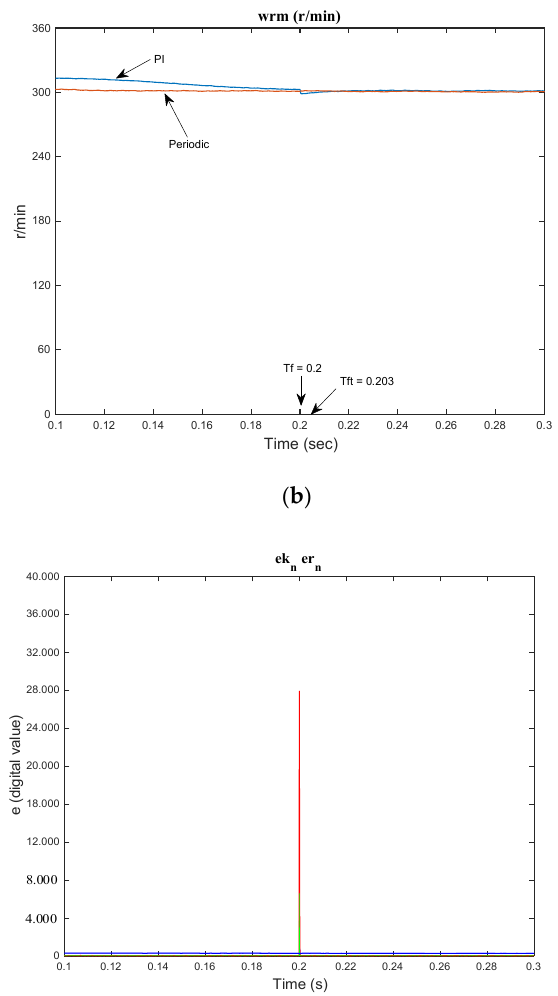
Figure 19. Simulated results of the fault-tolerant control when the a -phase was short-circuited: ( a ) currents of PI controller; ( b ) speed responses; ( c ) performance index.